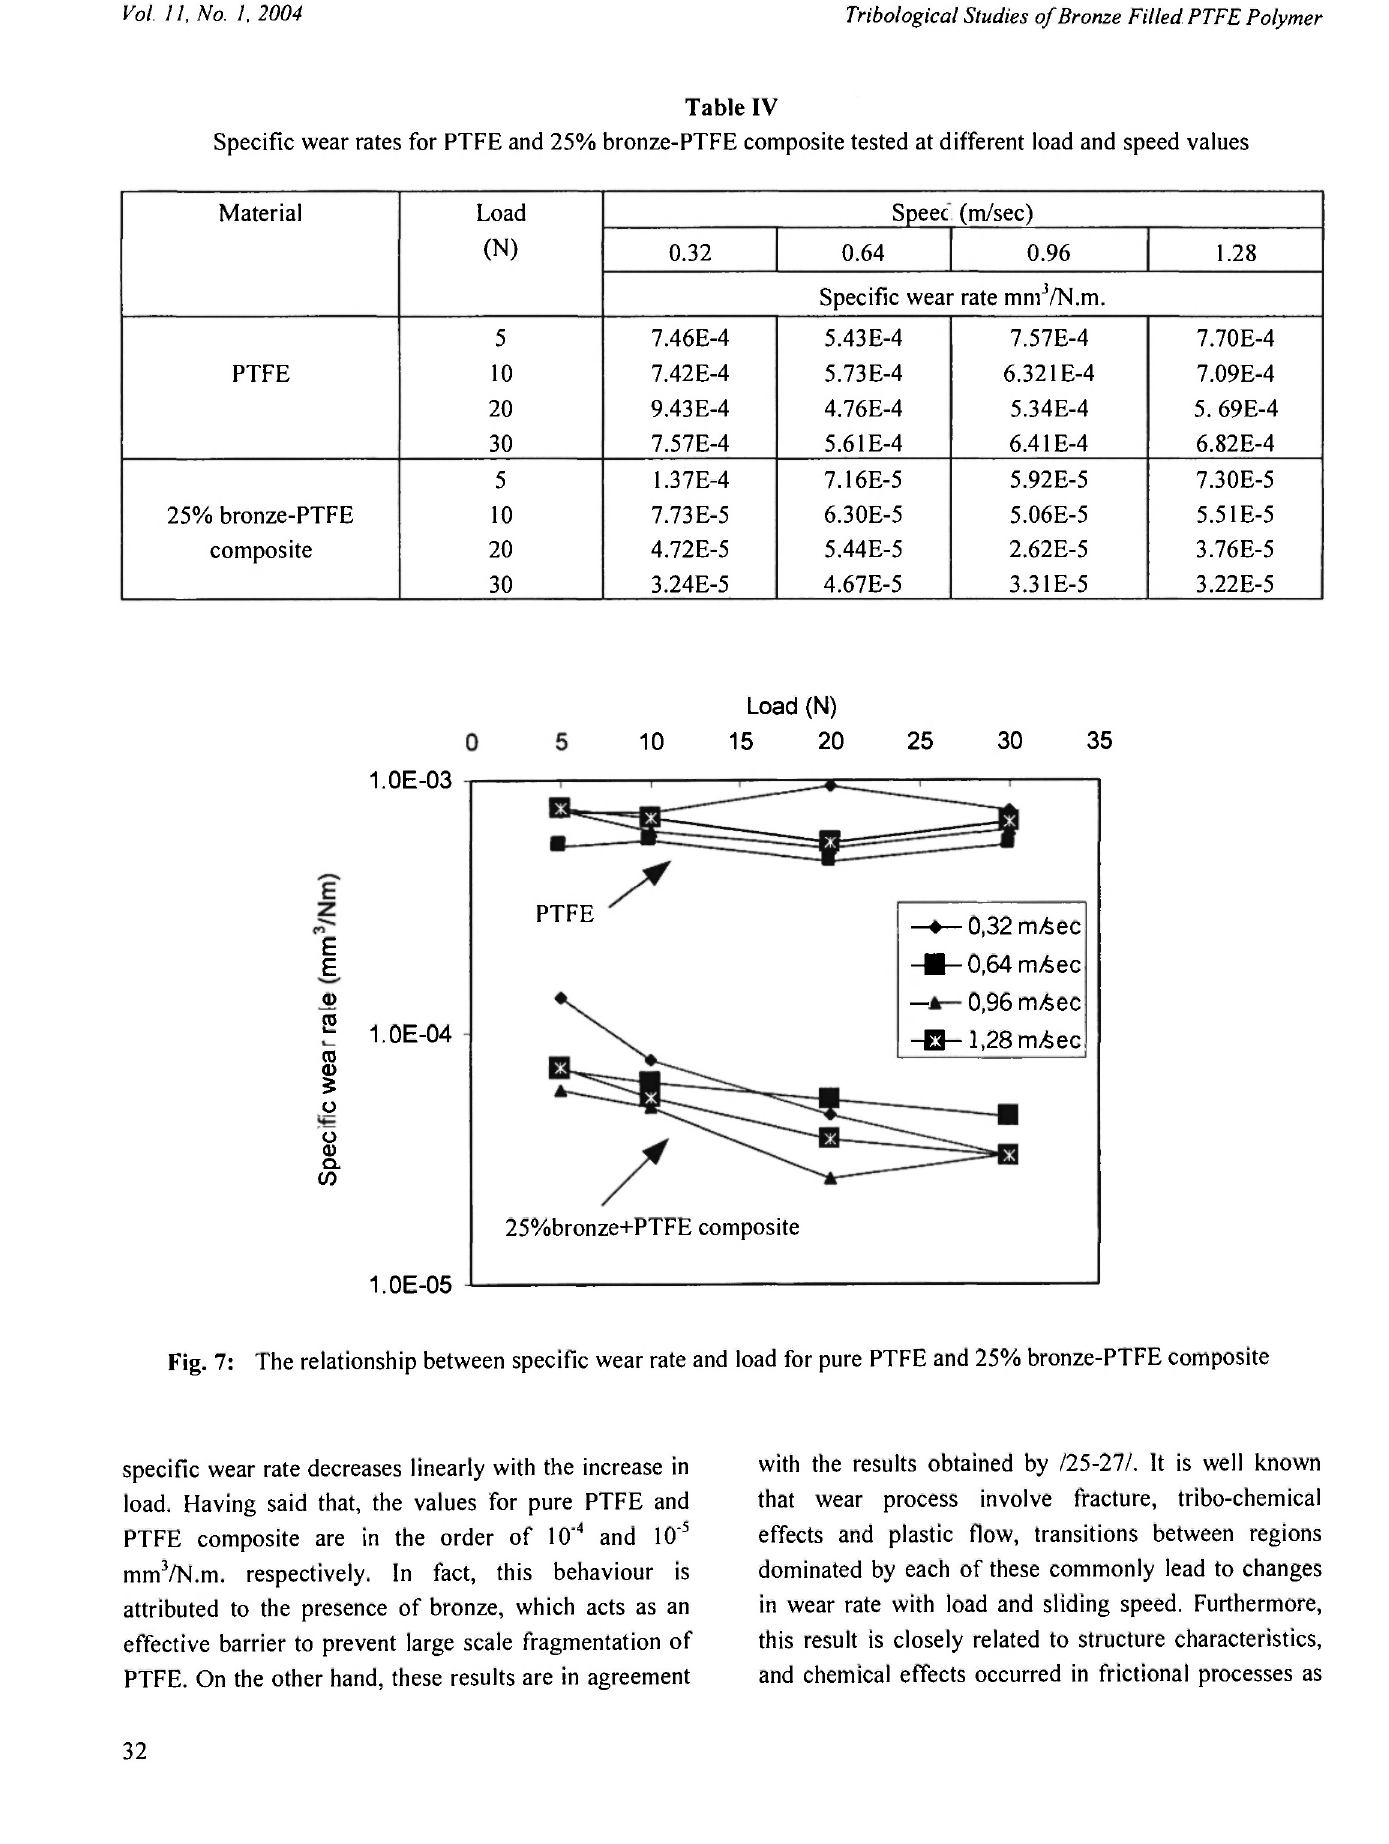
Specific wear rates for PTFE and 25% bronze-PTFE composite tested at different load and speed values